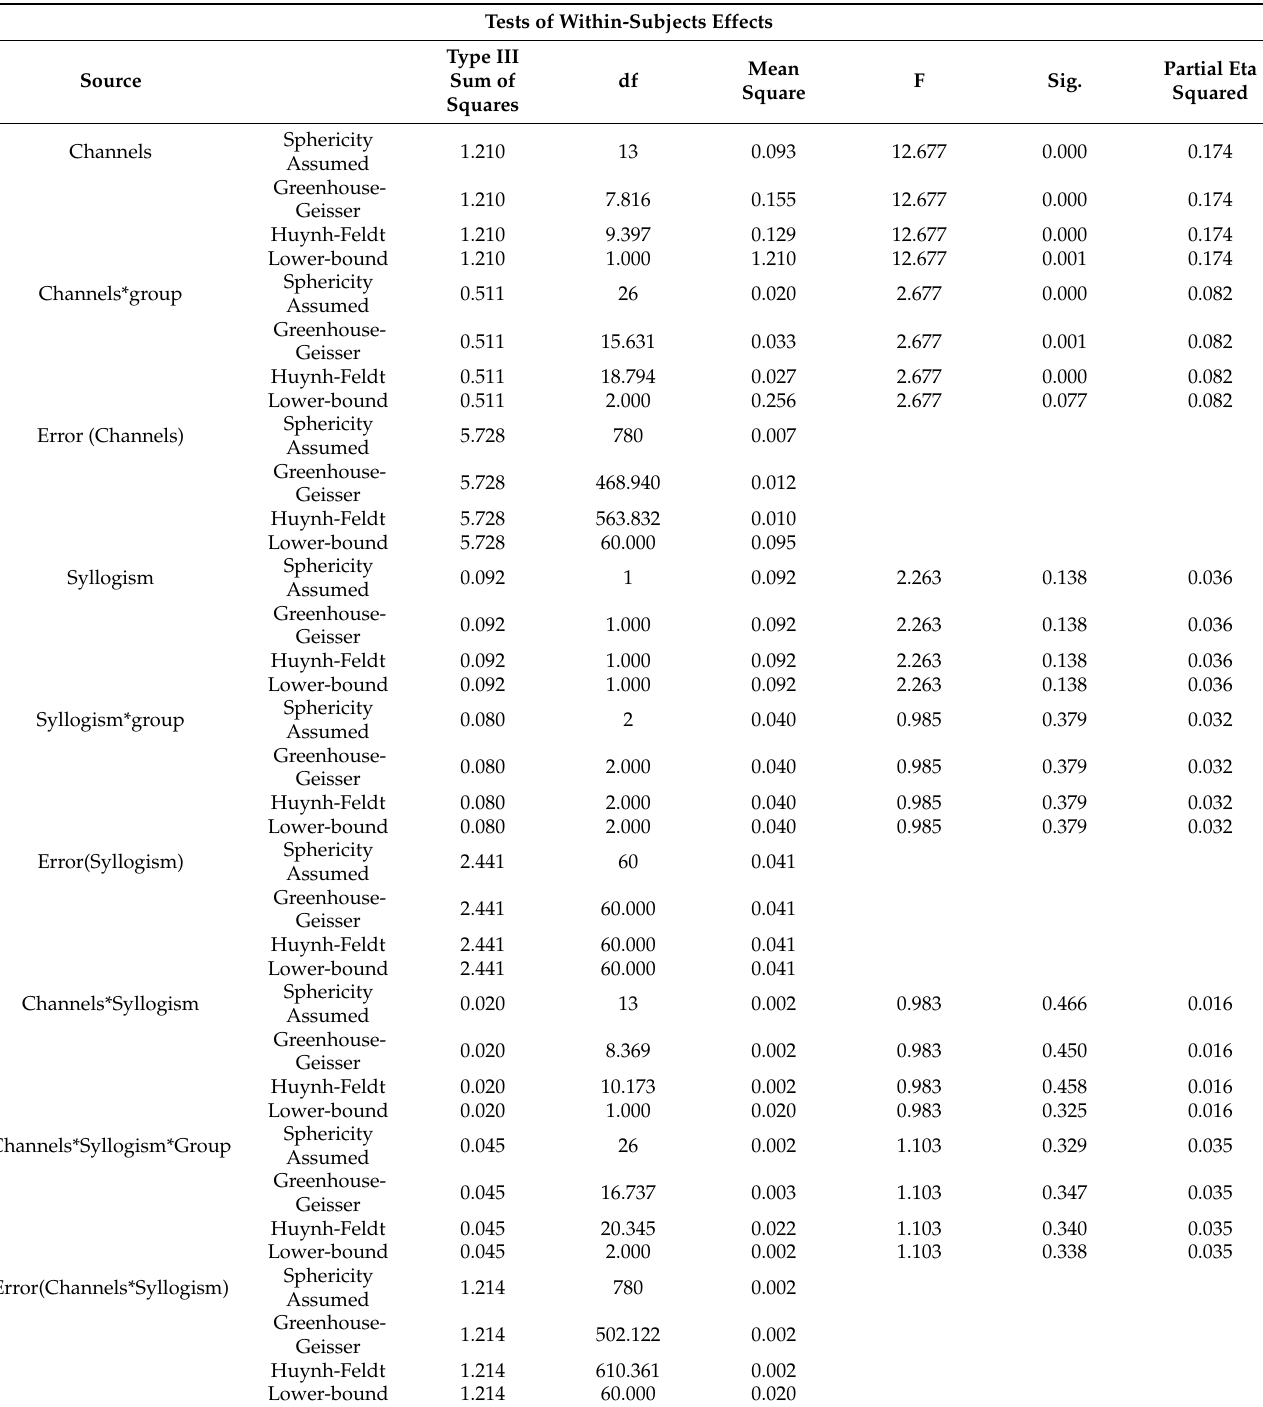
Table 5. Results of mixed ANOVA to test the within-subjects effects for MSE values (dependent variables). Tests of Within-Subjects